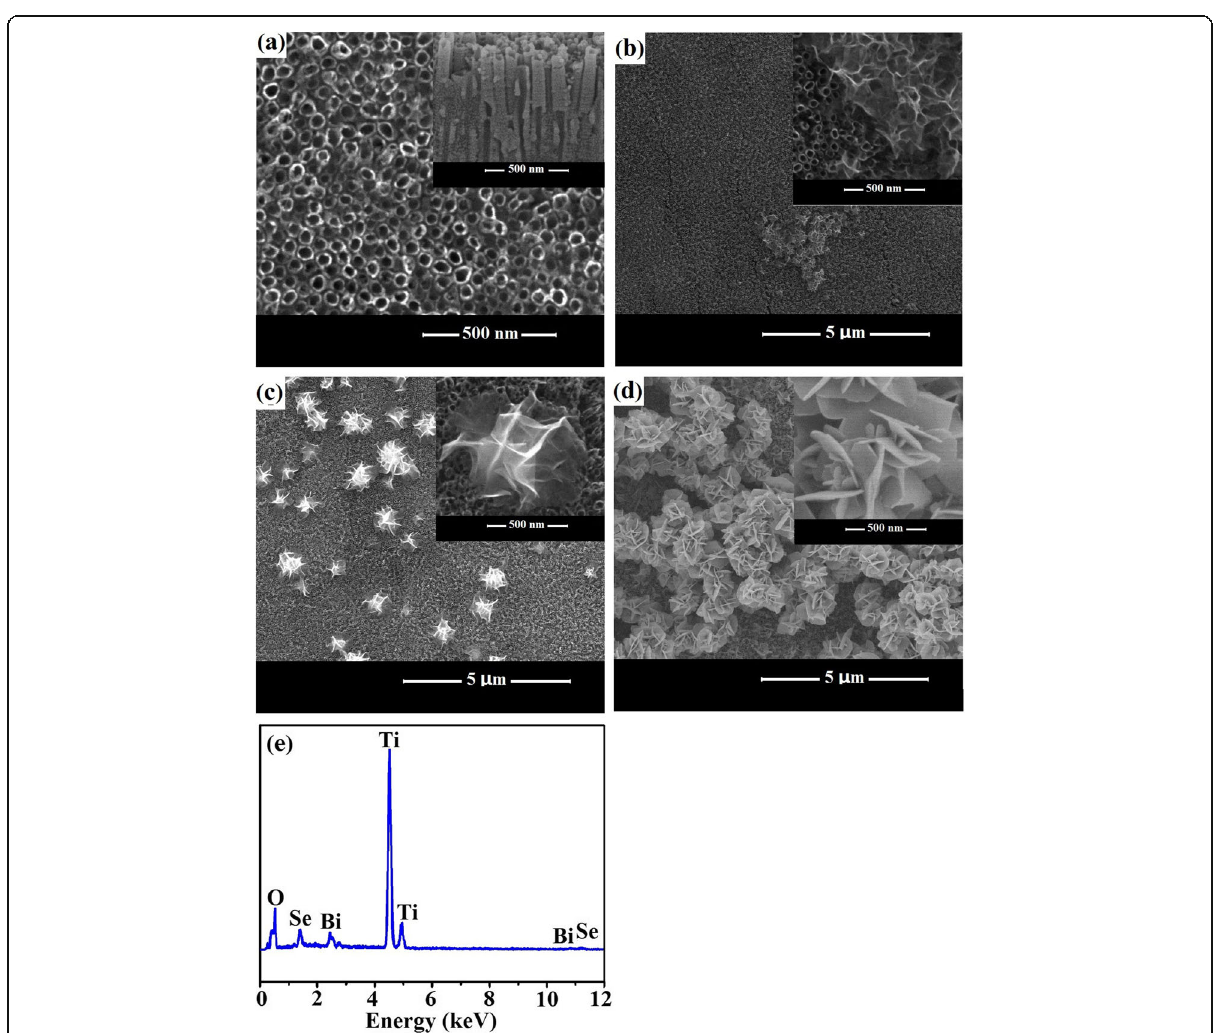
Fig. 2 SEM images for a pure TiO 2 , b Bi 2 Se 3 /TiO 2 -0.25, c Bi 2 Se 3 /TiO 2 -0.5 and d Bi 2 Se 3 /TiO 2 -1.0; e EDS spectrum for Bi 2 Se 3 /TiO 2 -0.5